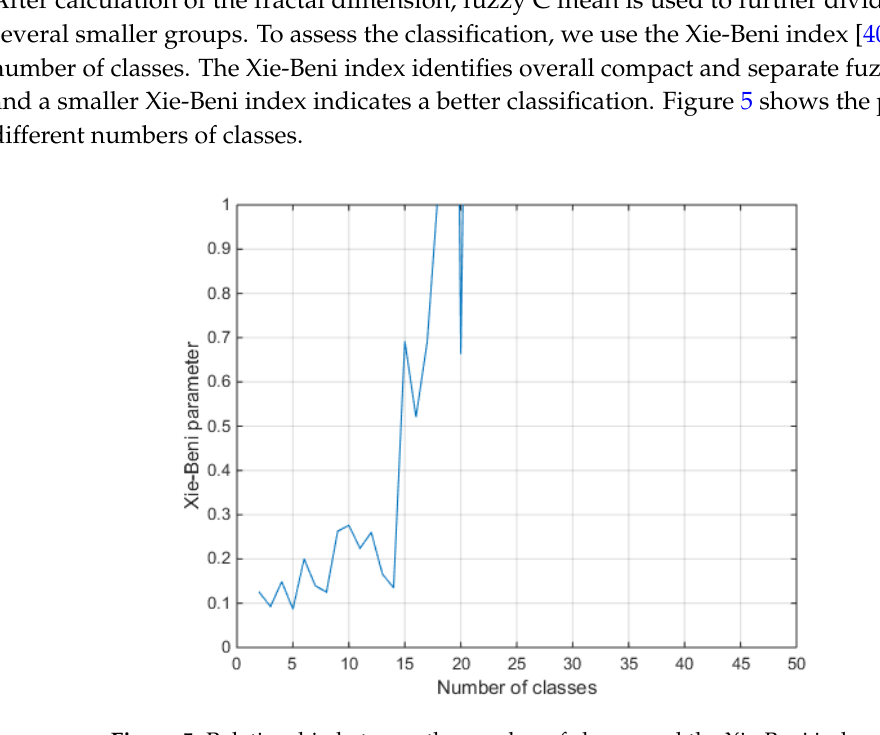
Figure 5. Relationship between the number of classes and the Xie-Beni index.